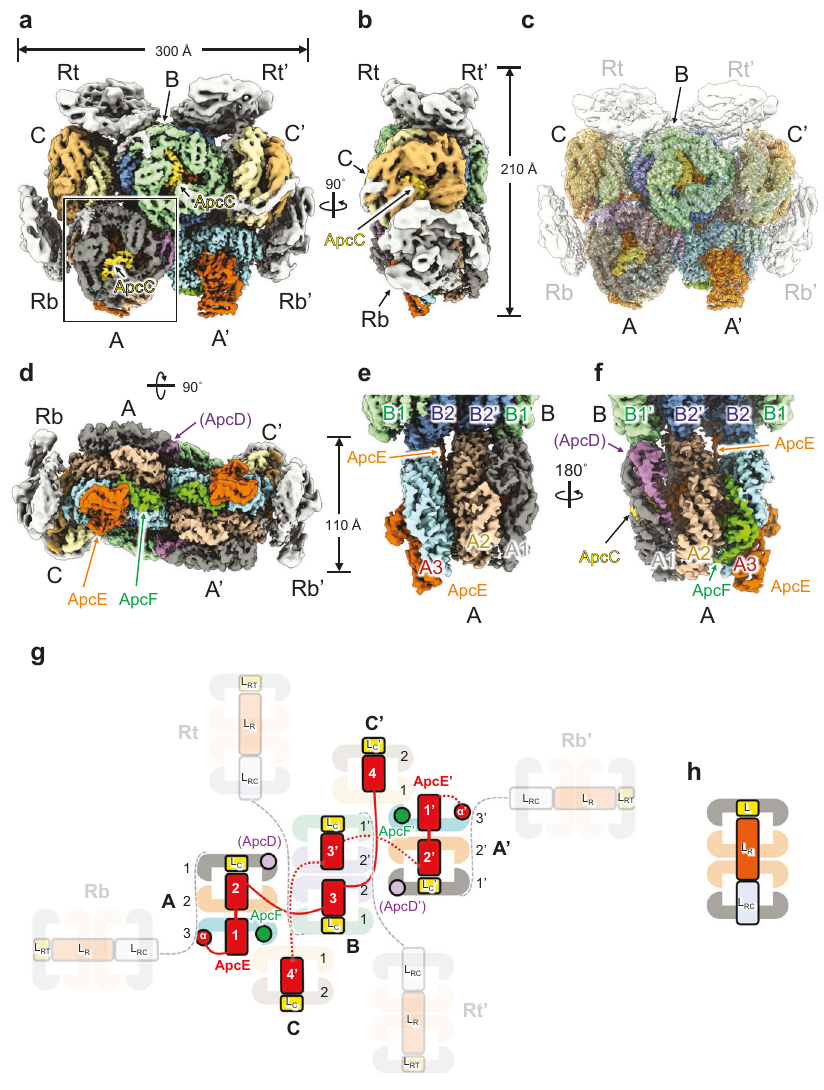
Fig. 1 Overall structure of the PBS core from T. vulcanus . Cryo-EM map of the PBS core from the front ( a , c ), side ( b , e , f ), and bottom ( d ) views. c It shows the superposition of the cryo-EM map and the re fi ned PBS core model. e Here it shows the structure inside the rectangle in a , enlarged and rotated 90 ˚ . f This shows e rotated 180 ˚ . g Schematic model of the pentacylindrical APC core (including A (A ’ ), B, and C (C ’ ) cylinders) and PC rods (Rb, Rb ’ , Rt, and Rt ’ ). ApcE (L CM ) containing α , Reps 1 – 4 and Arms 1 – 3 is shown in red. PC rods that did not build the model are shown in translucent. The PC rod models were drawn referencing the cryo-EM map in this study and the PBS structure from Nostoc 7120 7 . h Schematic model of the PC rod. CpcC (L R ), CpcD (L RT ), and CpcG (L RC ) interact within the two PC hexamers. The identi fi cation of ApcD is tentative. ApcD is shown in parentheses